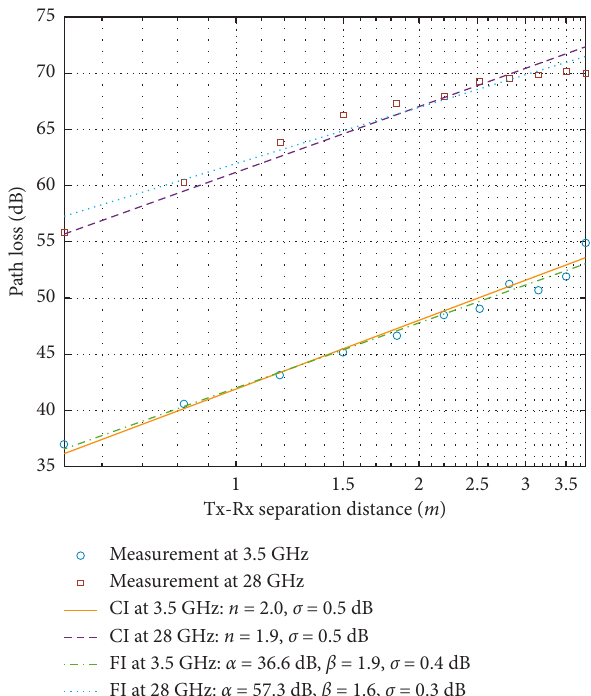
Figure 5: Measured path loss at 3.5 GHz and 28GHz along stairs compared with CI and FI models. Table 2: Path loss model parameters.